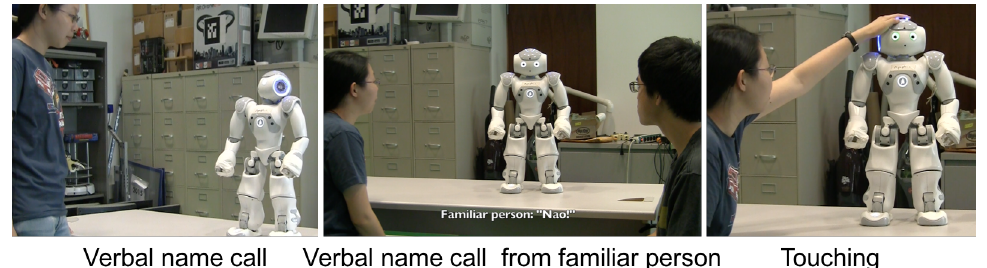
Figure 2: Example of stimulus families considered in this work, inspired by the ‘presses’ of the ADOS-2 tool. Shown pictures are for the ‘Calling name’ family. For the ‘Calling for joint attention’ family, the stimuli are: Verbal stimulus: ‘Look!’ - Verbal stimulus: ‘Look at THAT!’ - Activating the object. For the ‘Asking for snack preference’ family, the only stimulus is the verbal stimulus: ‘Which snack do you like?’. Table 1: Summary of the designed ‘autism-like’ robot behaviors of varying